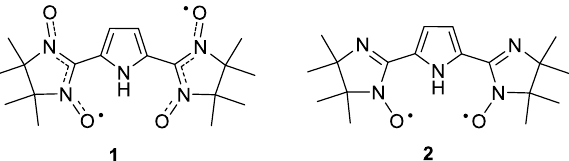
Figure 1. Chemical structure of bis(nitronyl nitroxide) 1 and bis(iminonitroxide) 2 diradicals.